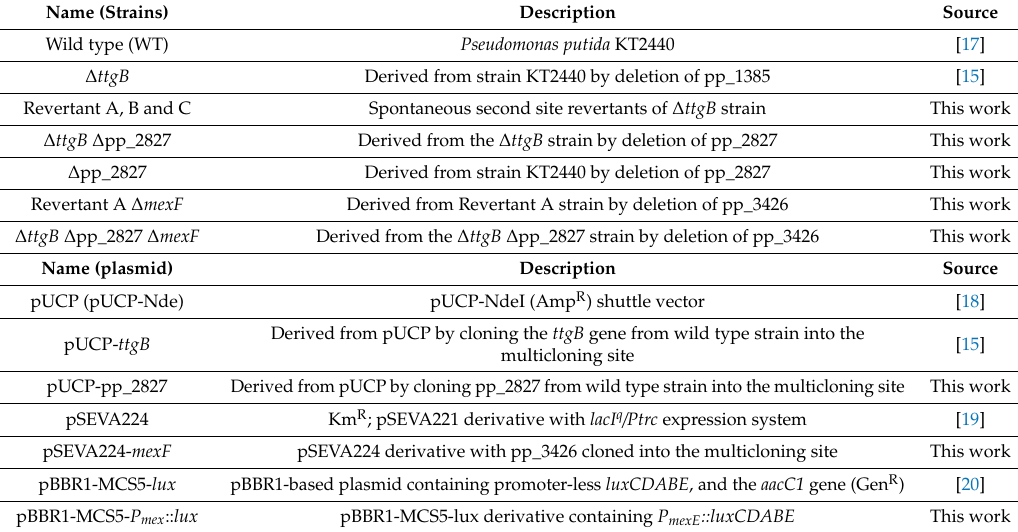
Table 1. List of strains and plasmids used in this